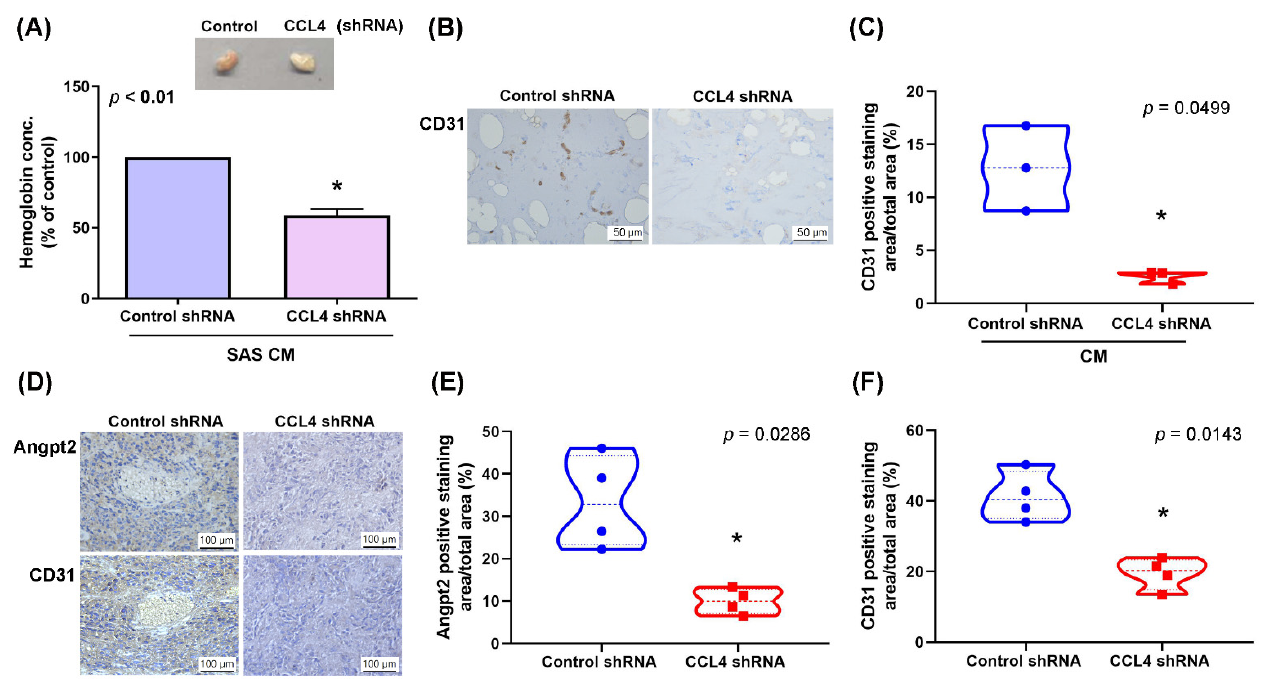
Figure 6. Silencing CCL4 expression inhibits tumor-induced angiogenesis in vivo. ( A – C ) Mice were injected subcutaneously with Matrigel OSCC CM for 14 days, after which time the plugs were excised, photographed and quantified for hemoglobin content ( A ), then stained with CD31 ( B , C ). ( D – F ) The tumor sections were immunostained using Angpt2 and CD31 antibodies. * p < 0.05 compared with controls.